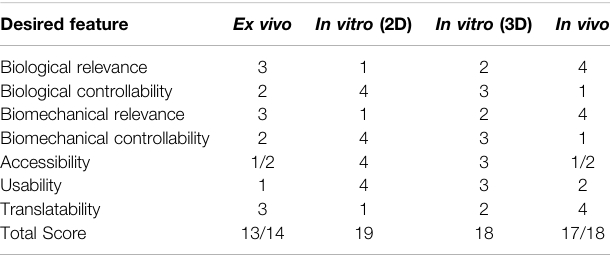
TABLE 3 | Summary chart of features desired by various model types for replicatingandcharacterizingtendonmechanoresponses(scale:1=lowestto 4 =